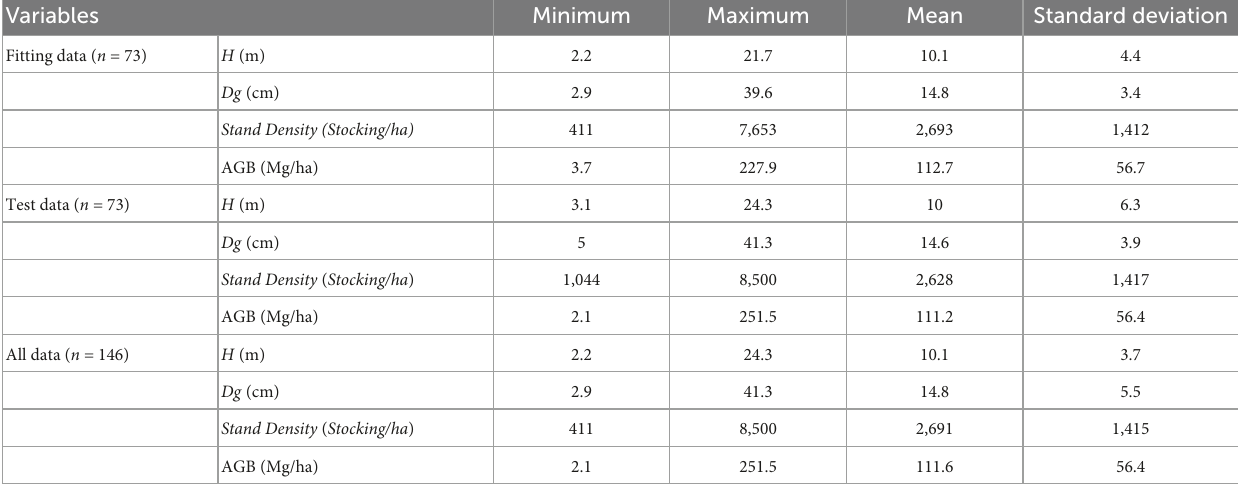
TABLE 1 The statistical parameters of sample plot datasets. Variables